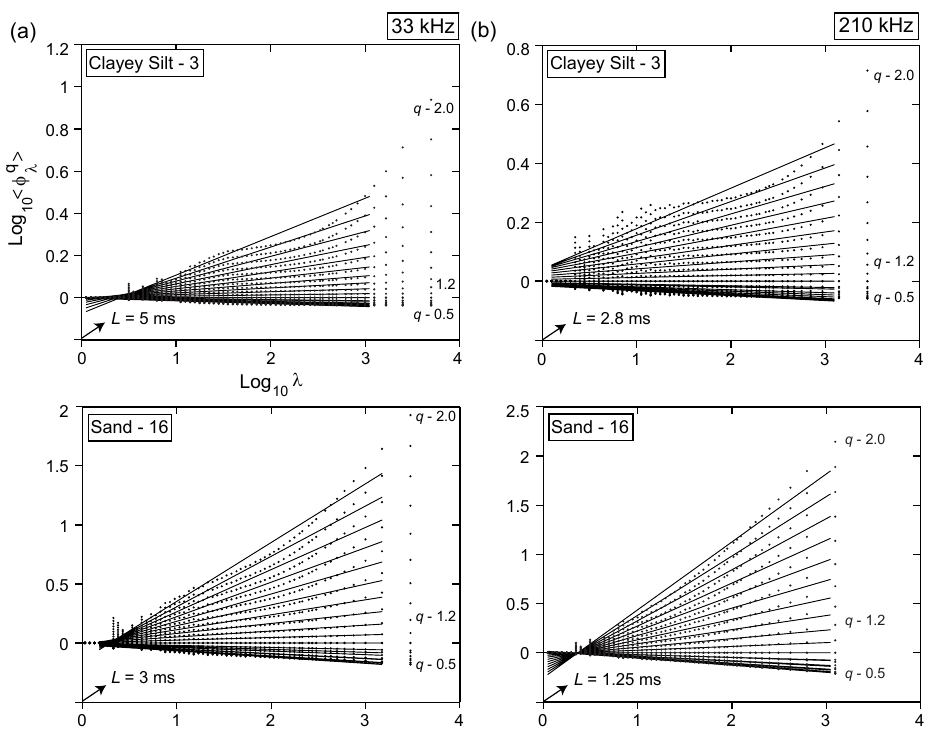
Fig. 3. Panels (a) and (b) shows the log/log plot of the normalized trace moments as a function of the scale ratio λ = L/l at 33 and 210kHz. The multiscaling of the statistical moments of the representative clayey silt and sand substrate is verified by the straightness of the curves. The q values of the each trace moments are varied between 0 and 2, in intervals of 0.1 (from top to bottom, q =2–1, 0.1, 0.9, 0.2, 0.8, 0.3, 0.7, 0.4, 0.6 and 0.5). The multiscaling of trace moments generally holds quite well up to q < 1.6. The deviation of trace moments (dots) from the fitted linear curve is indicative of “break” in the multiscaling. The break is less apparent for low q ( < 1.6) values, but becomes conspicuous for large q ( > 1.6) values. The break associated with the time-dependent seafloor backscattering is possibly due to the collective effect of inherent heterogeneities present in the seafloor (mainly because of the coarse sand particles, shells, gas bubbles, benthic organisms and sediment layers). Depending on acoustic wavelength/frequency, the individual features such as shells and other roughness elements at the sediment-water interface may be more appropriately characterized as discrete scatters than as micro topography (Jackson and Richardson, 2007). An appropriate assessment in this regard is difficult due to lack of supporting data (similar results were also reported earlier by Gagnon et al. (2006) and Lovejoy and Schertzer (2007b) while analyzing the high-resolution Lower Saxony DEM data over Germany. The break observed in their analyses was due to the effect of “trees” evident in the high-resolution topography